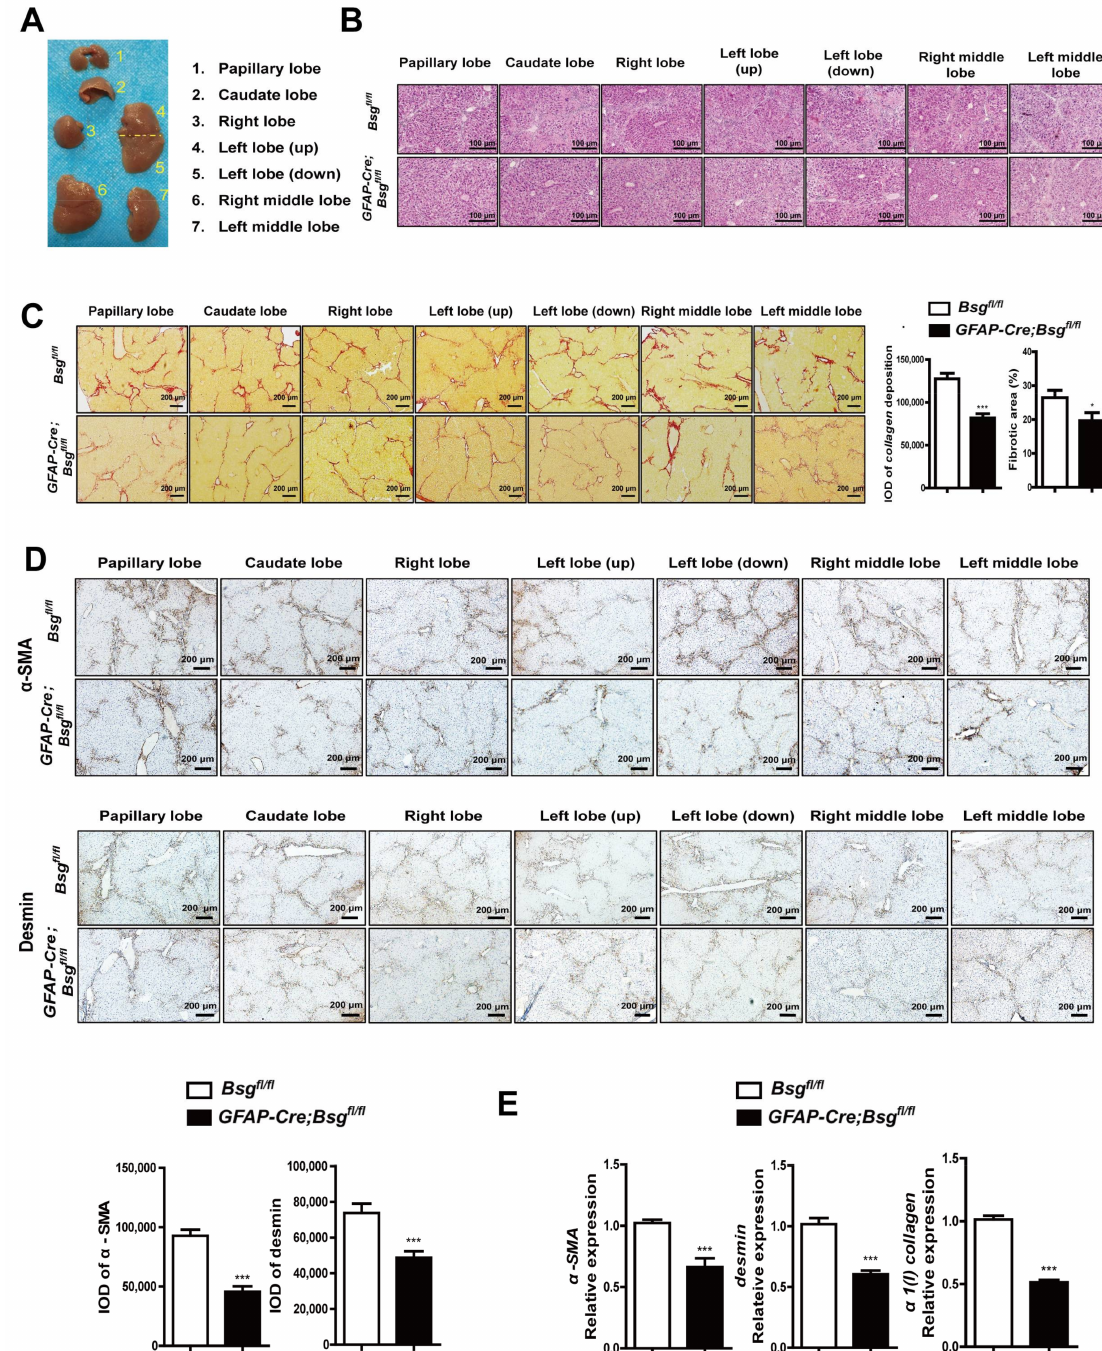
Figure 4. HSCs-specific deletion of CD147 alleviated CCl 4 -induced liver fibrosis Bsg fl/fl and GFAP-Cre;Bsg fl/fl mice treated with CCl 4 for eight weeks ( n = 4). ( A ) Representative photograph of seven parts of the mouse liver according to the anatomical structure; ( B ) Representative microphotograph of HE-stained paraffin-embedded sections of liver tissues; ( C ) Representative microphotograph of sirius red-stained paraffin-embedded sections of liver tissues (left), statistical analysis of integrated option density (IOD) and expression area percentage of sirius red collagen deposition (right); ( D ) Representative microphotograph of immunohistochemistry analysis of α -SMA and desmin (up), statistical analysis of IOD of α -SMA and desmin (down); ( E ) Real-time RT-PCR detection of hepatic gene expression of α -SMA , desmin and α 1(I) collagen . GAPDH was used as the normalization control. The results were shown as the mean ± SD. * p < 0.05, *** p <